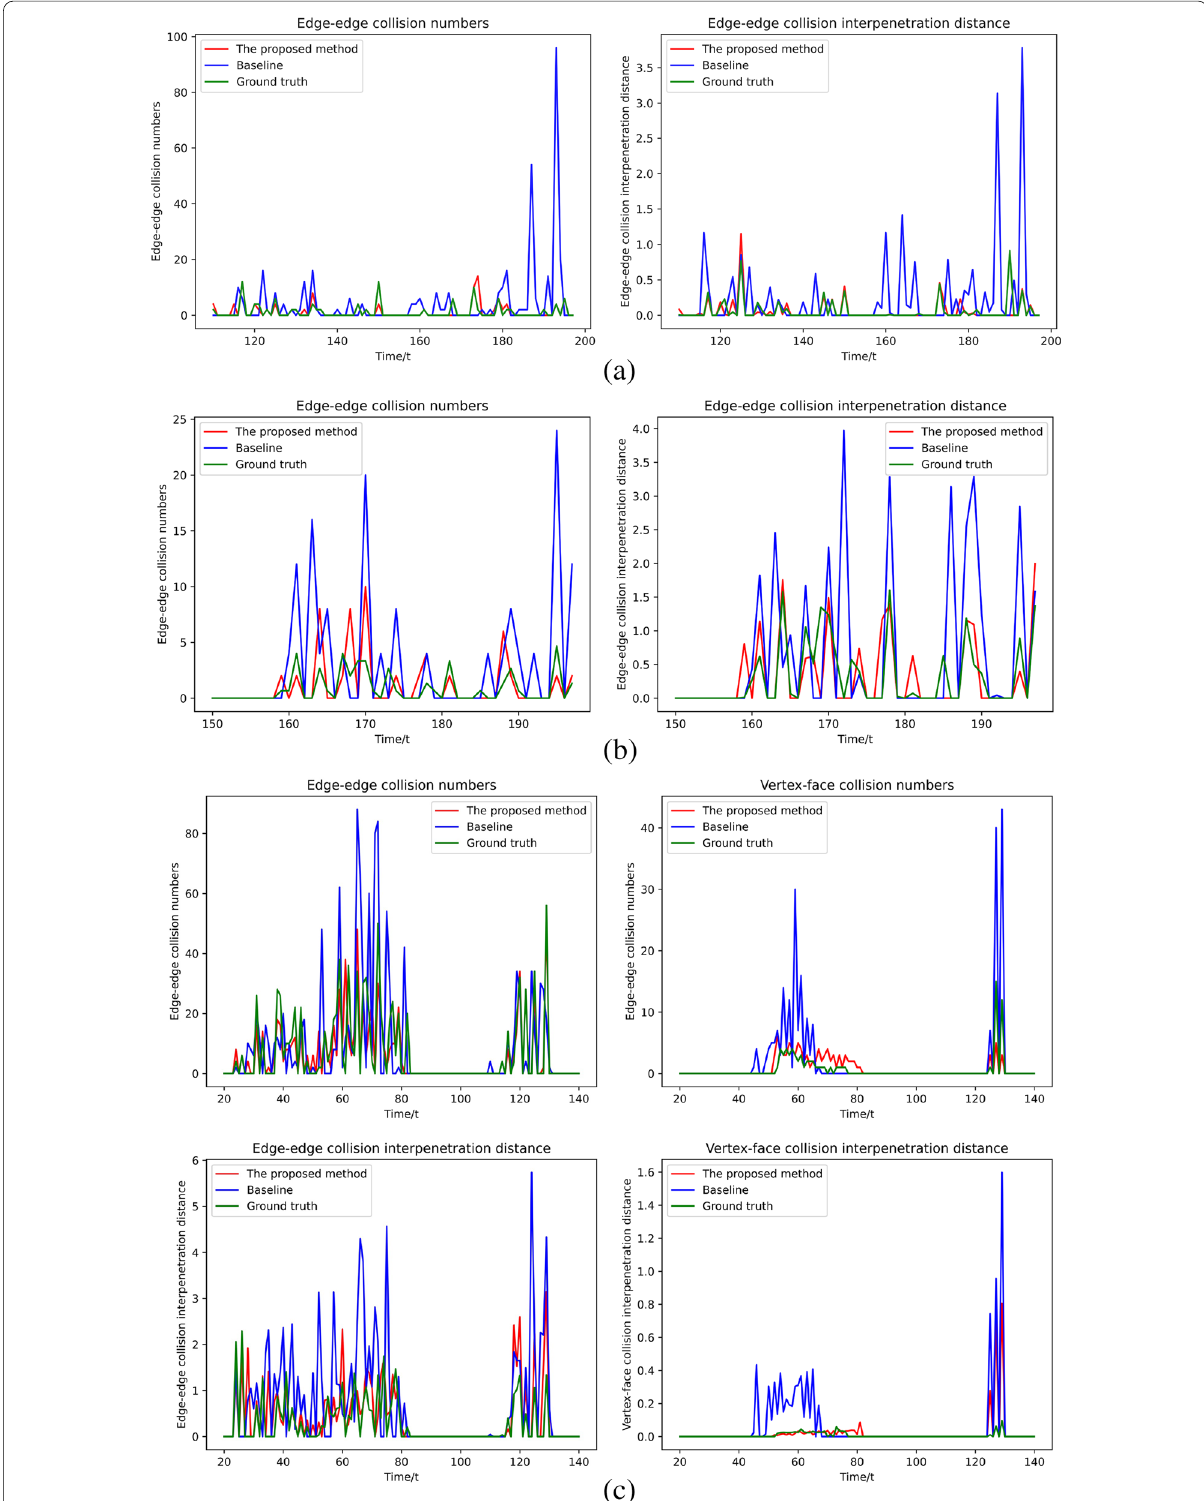
Fig. 8 Quantitative evaluation. The proposed method is evaluated using the numbers and interpenetration distance of vertex‑face and edge‑edge collisions. a : Vertex‑face collision evaluation; b : Edge‑face collision evaluation; c : Face‑face collision